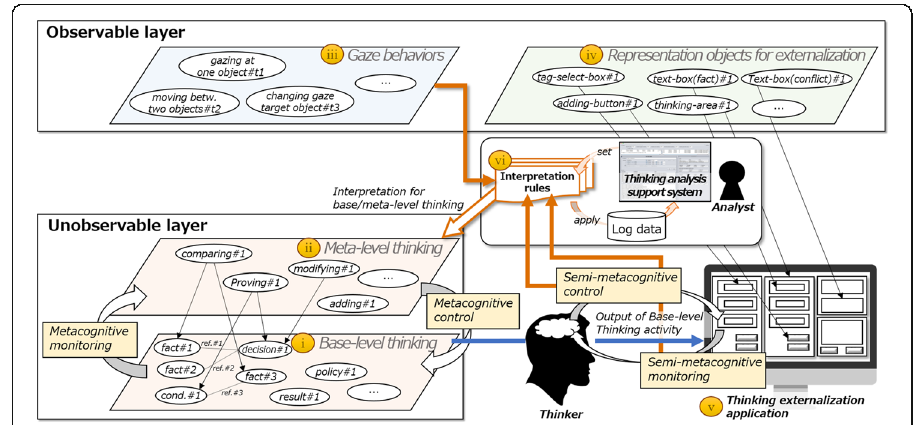
Fig. 1 Interpretation model to capture meta-level thinking